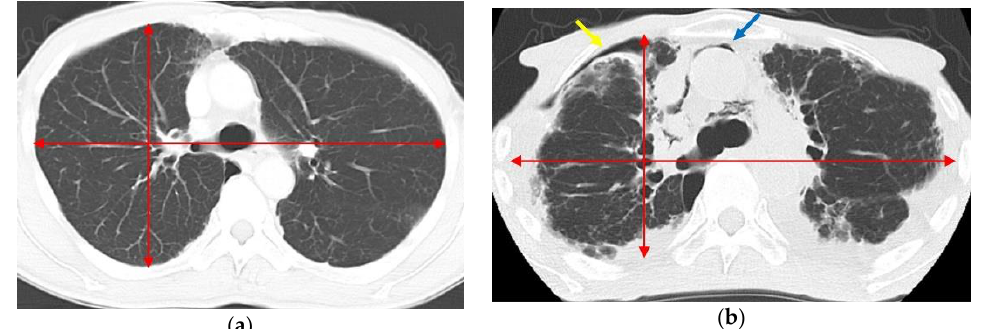
Figure 2. Chest CT images of a patient with idiopathic pleuroparenchymal fibroelastosis (IPPFE). ( a ) Chest CT before the diagnosis of IPPFE at the level of the sixth thoracic vertebra. The bilateral lungs are almost normal. ( b ) Chest CT 7 years later at the same level. The anteroposterior diameter of the thoracic cage has become shortened. Shrinking of the lungs has resulted in an air space in the right chest cavity (yellow arrow) and pneumomediastinum (blue arrow), indicating air leak syndrome. Abbreviations: CT—computed tomography; IPPFE—idiopathic pleuroparenchymal fibroelastosis.